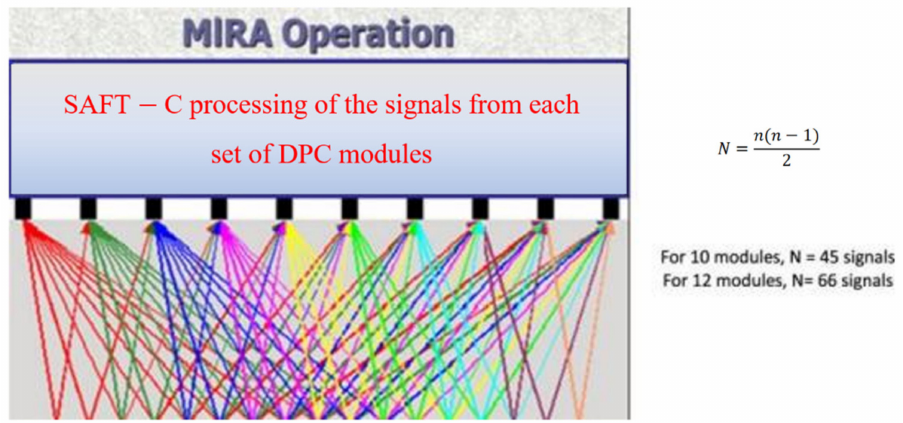
Figure 9. Schematic representation of the digitally-focused array signal capturing scheme